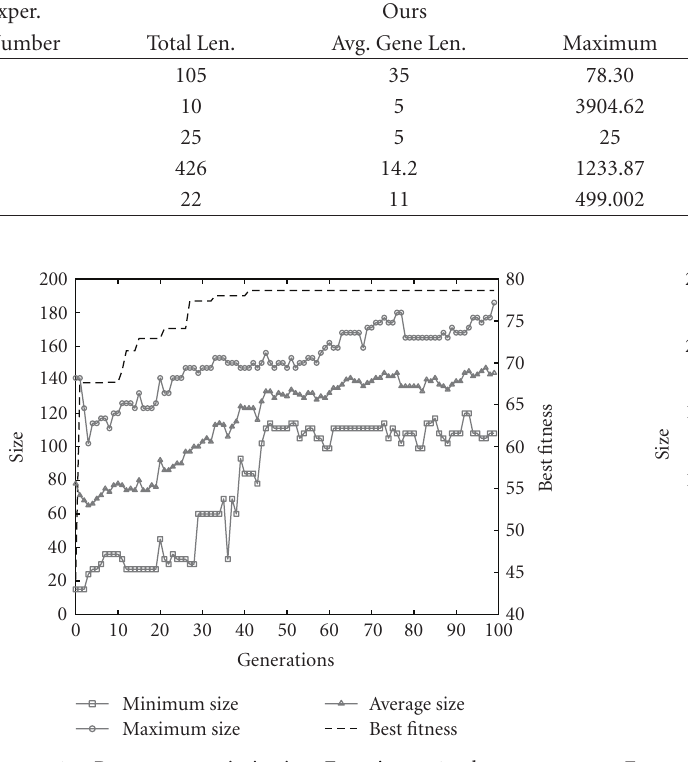
Figure 15: Parameter optimization Experiment 1: chromosome sizes and best fitness.